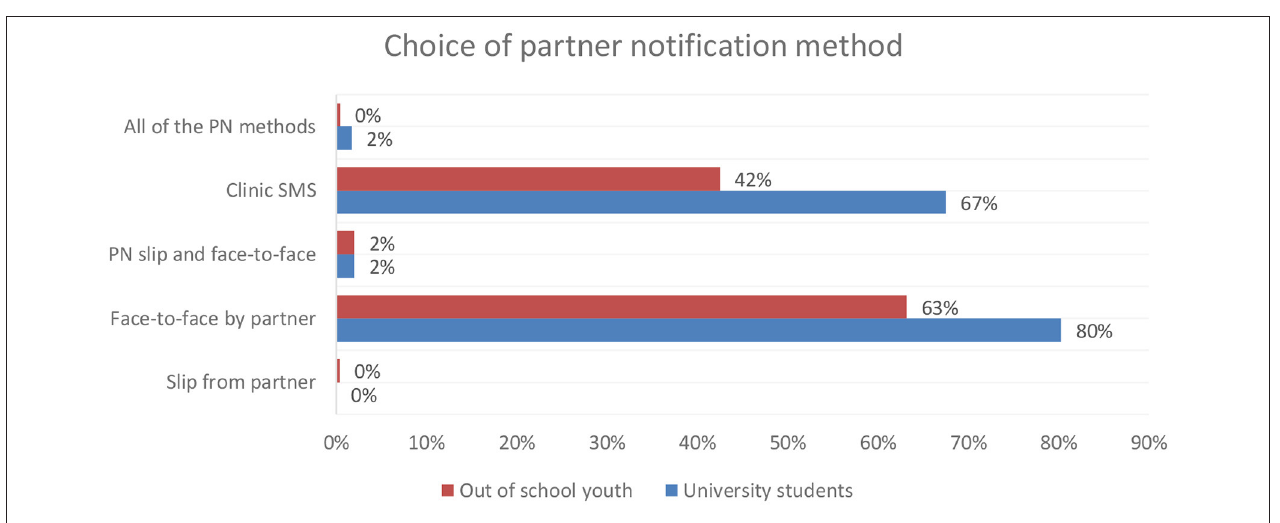
FIGURE 2 | Choice of partner notification if partner is diagnosed with an